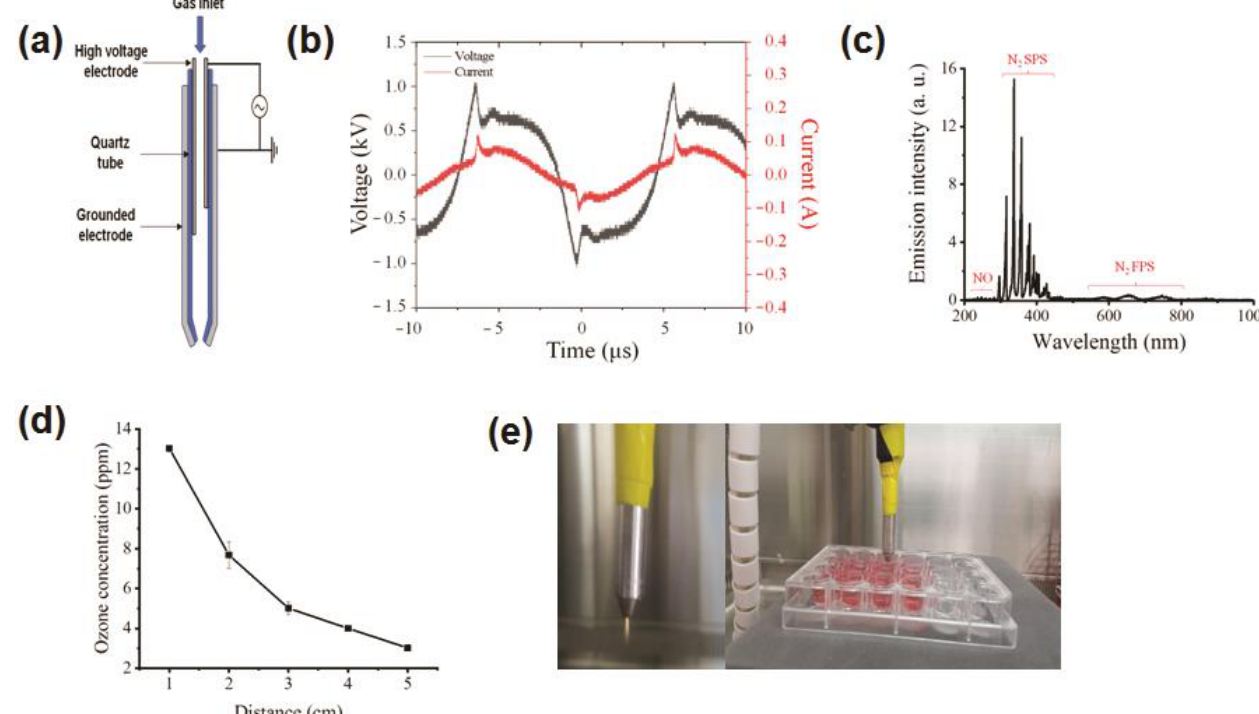
Figure 1. ( a ) Schematic outline of the experimental setup. ( b ) Current and voltage waveforms through plasma discharge. ( c ) Optical emission spectra (OES) measurement for soft plasma jet device by air gas. ( d ) Measurement of ozone concentration at different distances of treatment. ( e ) Photograph of the soft plasma jet.